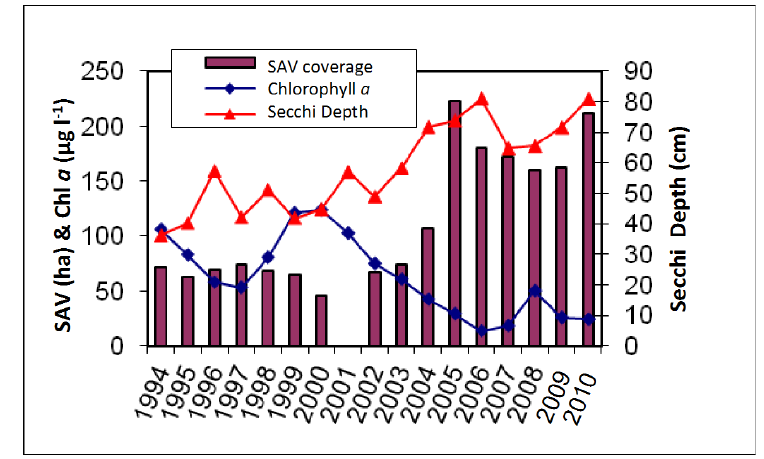
Figure 3. SAV acreage plotted with Chlorophyll a and Secchi Depth measurements in Gunston Cove from 1994–2010. Time series of measurements started a year after SAV appeared in Gunston Cove. Water 2017 , 9 , 421